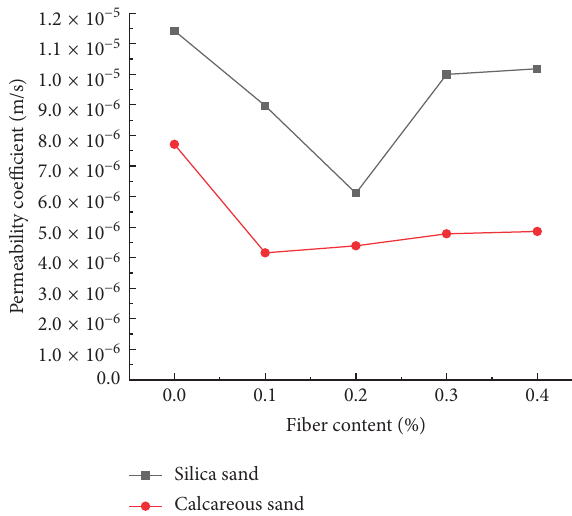
Figure 9: The permeability coefficient of the sample with different fiber